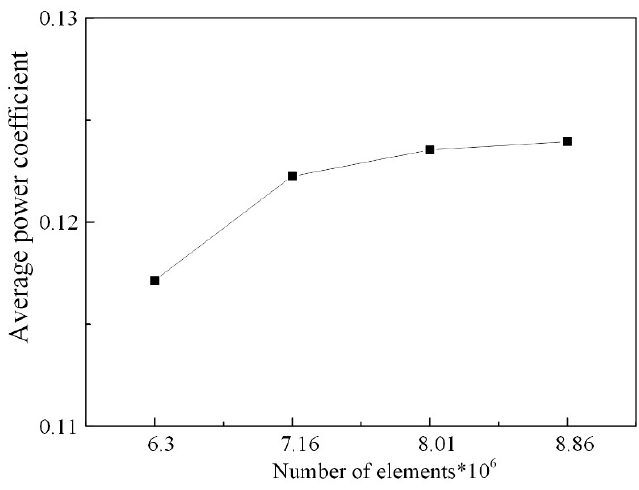
Figure 2. Mesh density independence test.